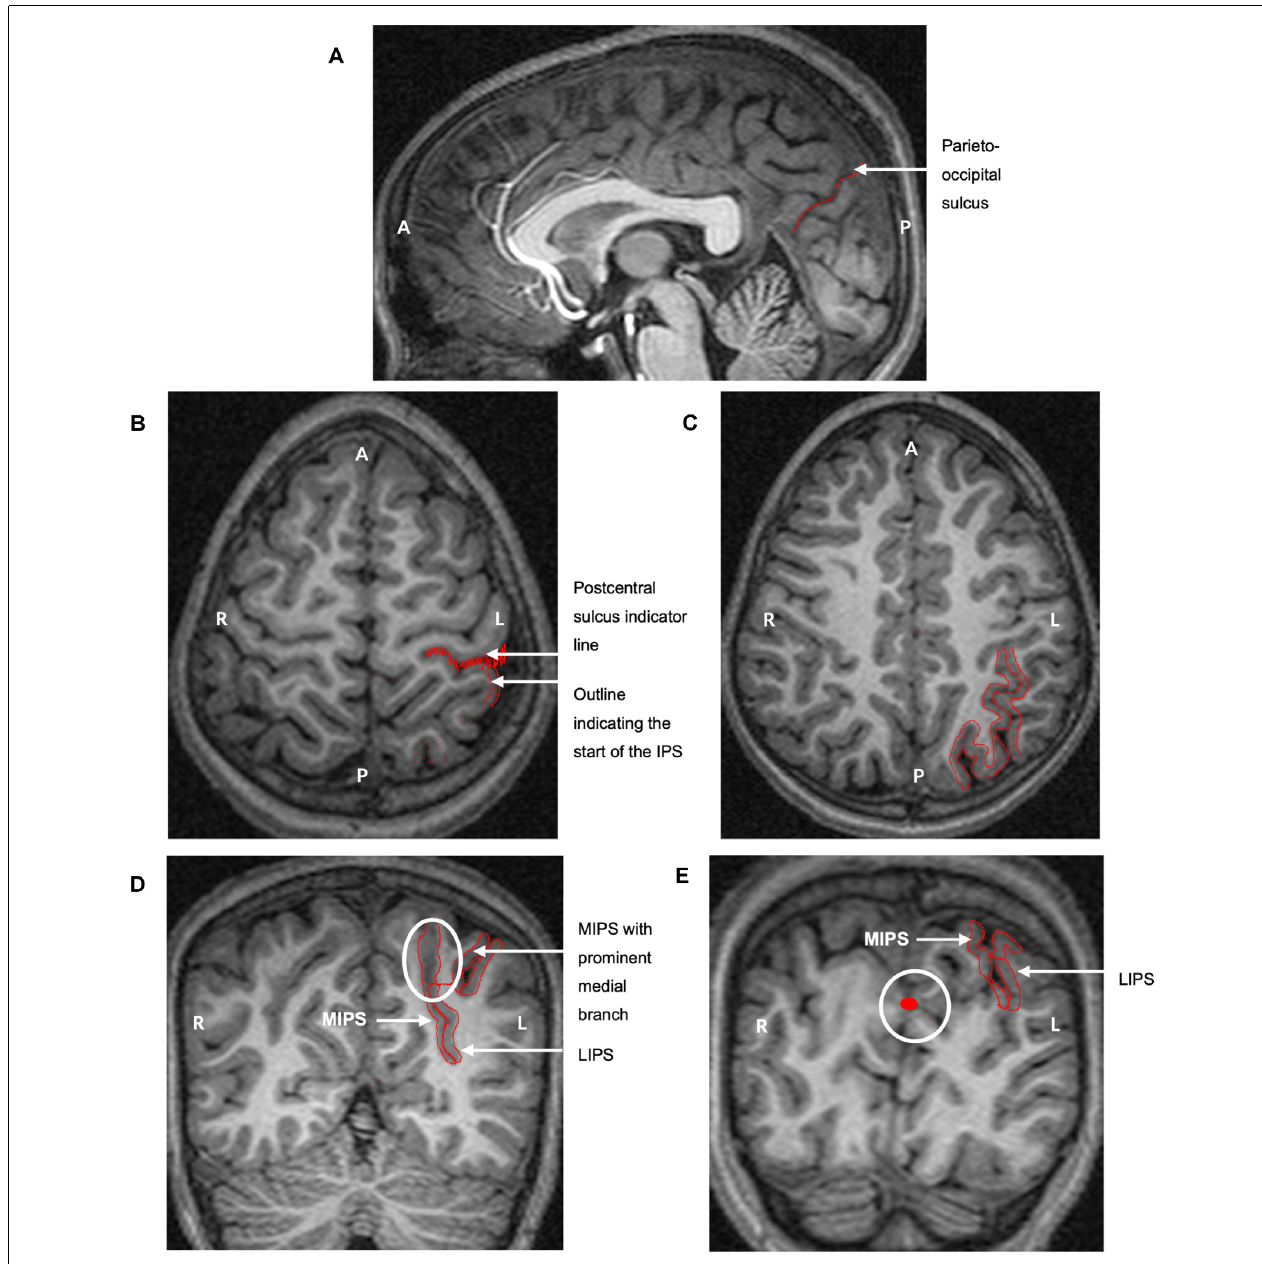
FIGURE 1 | The protocol for manually parcellating the intraparietal sulcus (IPS) is shown on the left hemisphere of a child with fetal alcohol syndrome (FAS)/partial FAS (PFAS). Both the medial (MIPS) and lateral (LIPS) walls of the IPS were traced. (A) The parieto-occipital sulcus was first identified on the sagittal plane to indicate the end of the parietal portion of the IPS. Tracings on the transverse planes serve to indicate (B) the start of the IPS at the postcentral sulcus and (C) the pattern of the sulcus. (D) The IPS was finally traced on the coronal sections. The white ellipse indicates the medial branch that was always present near the end of the parietal portion. The thin red line connecting the two sulci is required by the software for the total volume calculation as the area traced must be one continuous structure. (E) The white circle indicates tracings from sagittal slices that are visible on the coronal planes, clearly indicating the parieto-occipital border of the IPS (A, Anterior; P, Posterior; L, Left hemisphere; R, Right